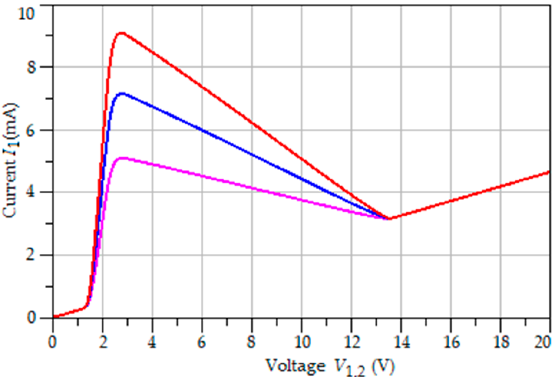
Figure 18. Current-voltage characteristics of the NDR circuit with multiple-output Wilson current mirror; m = 0—purple curve, m = 1—blue curve, m = 2—red curve.